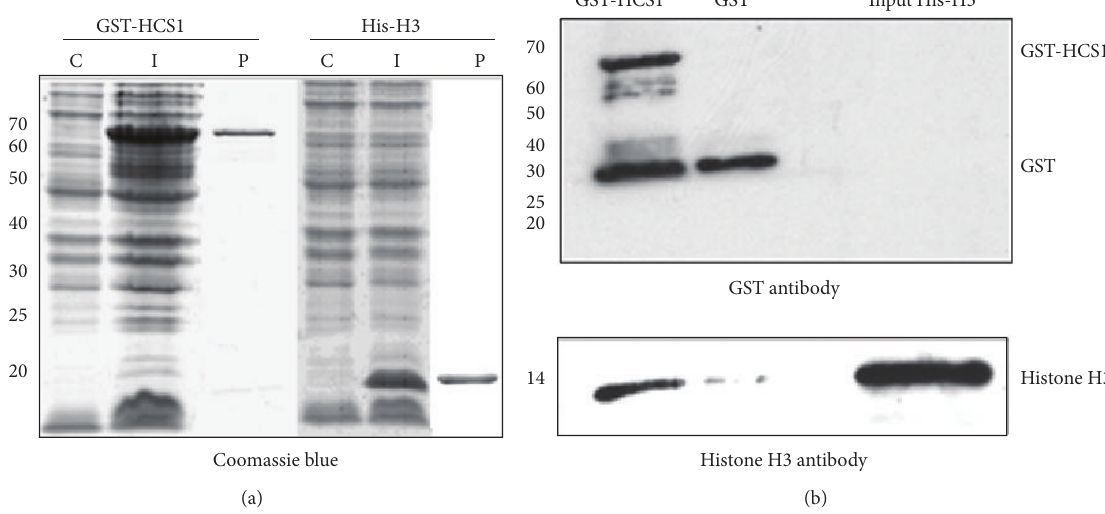
Figure 5: HCS1 interacts with Arabidopsis histone H3 directly in vitro . E. coli lines that contain GST-HCS1, His-H3, or GST construct were induced to express these genes. After induction, total protein was extracted from the cell lines. Recombinant His-histone H3 protein was purified from E. coli by using metal affinity chromatography. Recombinant GST-HCS1 or GST alone was purified from E. coli by using glutathione-sepharose beads. Proteins were subjected to GST pull-down assays with GST-HCS1 or GST alone and probed by western blot to detect whether there was an interaction between HCS1 and histone H3. (a) Proteins were analyzed by 15% SDS-PAGE and stained with Coomassie Blue. I: total proteins extracted from E. coli containing a GST-HCS1 or a His-H3 construct. C: total proteins extracted from control E. coli (not containing any vector). P: recombinant GST-HCS1 or recombinant His-H3 proteins. (b) Western blot of proteins after GST pull- down to detect whether there was an interaction between HCS1 and histone H3. GST-HSC1 fusion protein and GST were detected with GST antibody; Histone H3 was detected with corresponding antibody. GST-HCS1: the proteins released from the beads coupled with GST-HCS1 after being incubated with His-histone H3 proteins; Histone H3 pulled down by GST-HCS1 was detected. GST: the proteins released from the beads coupled with GST control after being incubated with His-histone H3 proteins; no histone H3 was detected. Input His-H3: 10% of the total input recombinant His-histone H3 proteins; Histone H3 was strongly detected as expected. Experiments were conducted in triplicate. 2X SDS loading buffer. After boiling and centrifugation,